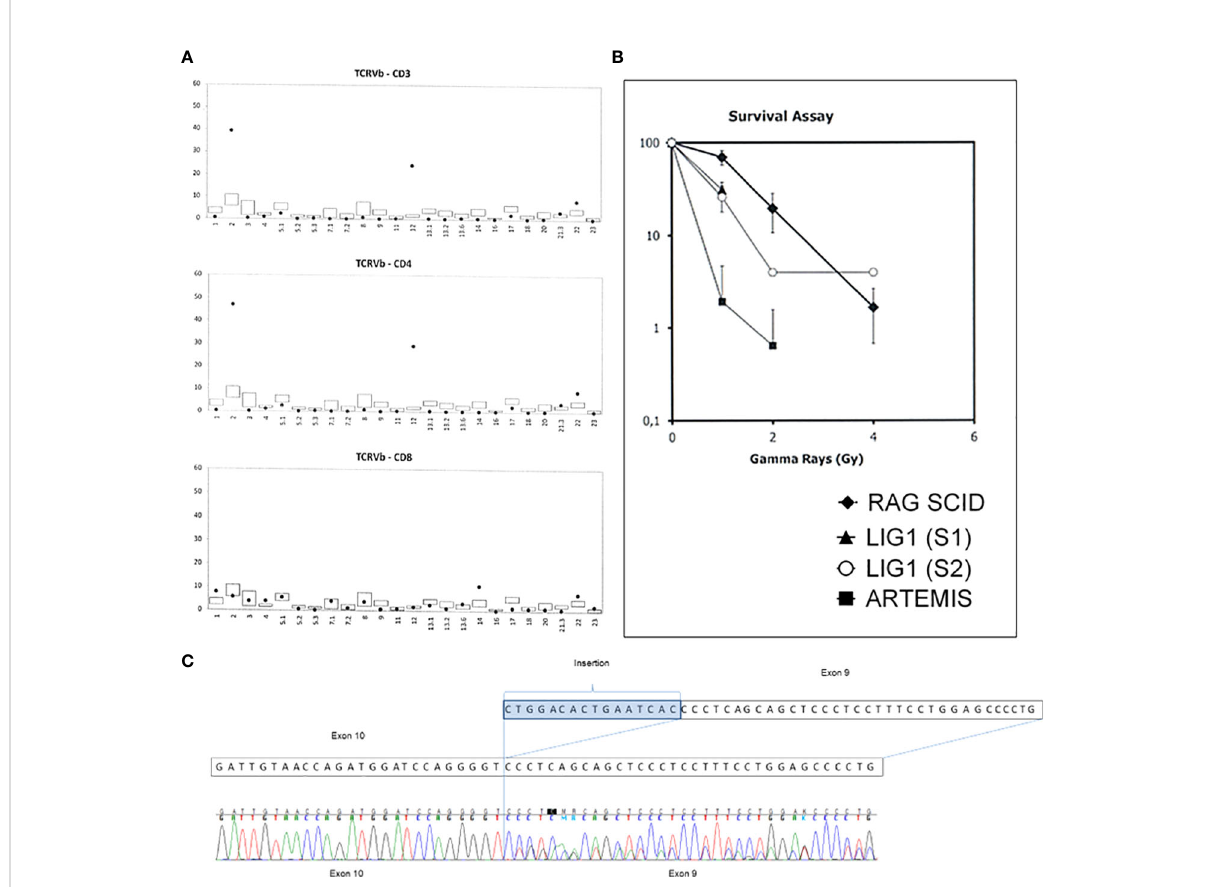
FIGURE 3 Diagnostic key-tests in the LIG1 de fi ciency patient. (A) Distribution of V b chain of the TCR receptor is oligoclonal with a signi fi cantly increased percentage of V b 2 and V b 12 chains among CD4 lymphocytes. (B) Clonogenic survival assay results. Fibroblasts cultured from skin biopsies of the patient and an Artemis-de fi cient SCID patient were exposed to increasing dose of irradiation and the percentage survival (axe Y) was determined after 8 days. S1- sample 1, S2- sample 2. RAG1 SCID patient sample was used as a control. (C) The cDNA sequencing results showing the splice site variant in the LIG1 which leads to an insertion of sixteen nucleotides in the exon 9 resulting in a shift of a reading frame and a premature protein termination at position